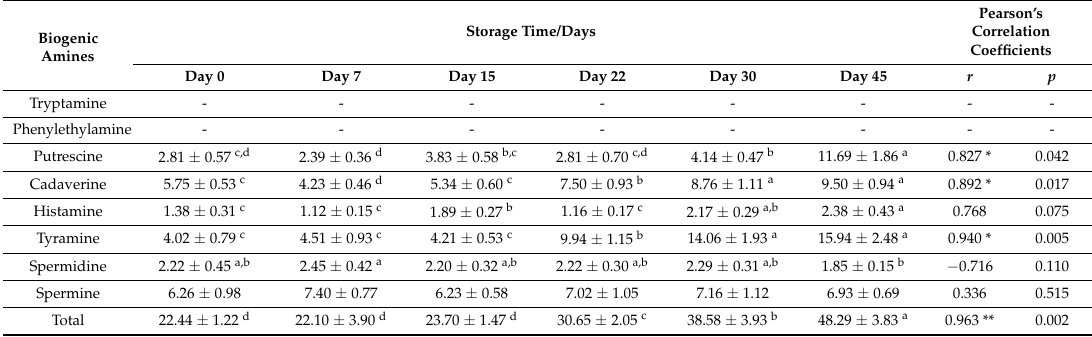
Table 4. BA concentrations (mg/kg) in the bacon after at 0, 7, 15, 22, 30, and 45 days of refrigerated